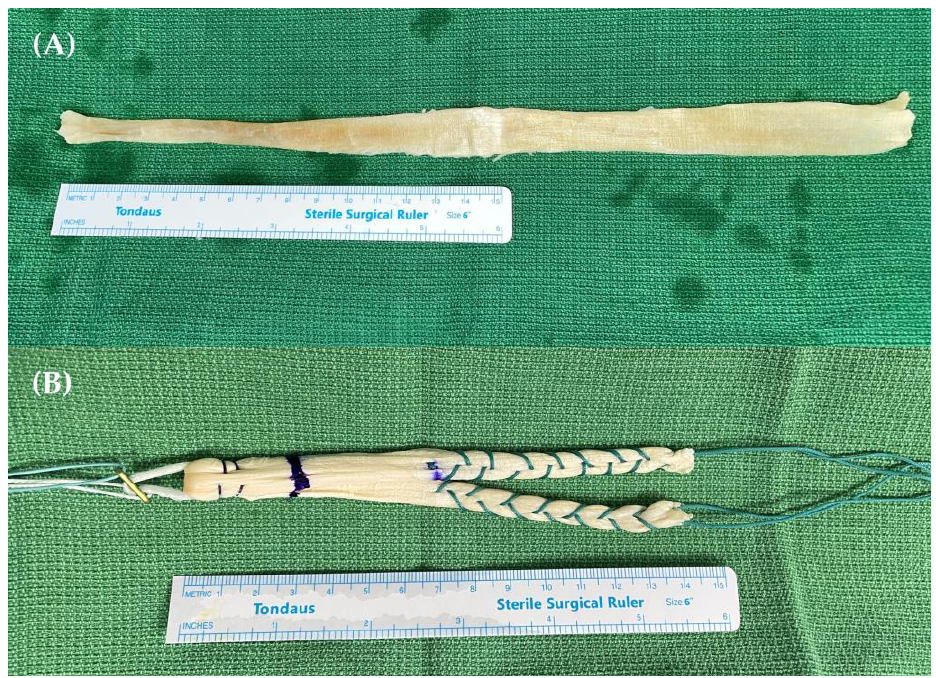
Figure 2. The allogenic tibialis anterior tendon ( A ) before and ( B ) after the preparation. Crutch-assisted walking was initiated 1 d after surgery. Full weight-bearing